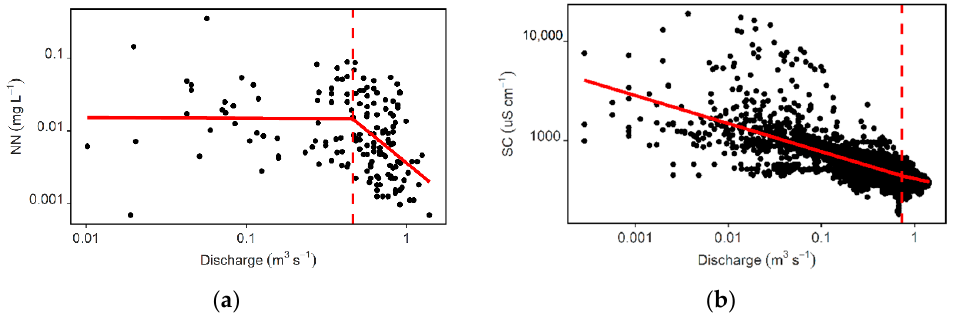
Figure 4. Concentration–discharge ( C–Q ) relationship plots for water quality constituents with discharge thresholds: ( a ) nitrate-nitrite (NN) and ( b ) specific conductance (SC) at SRS.